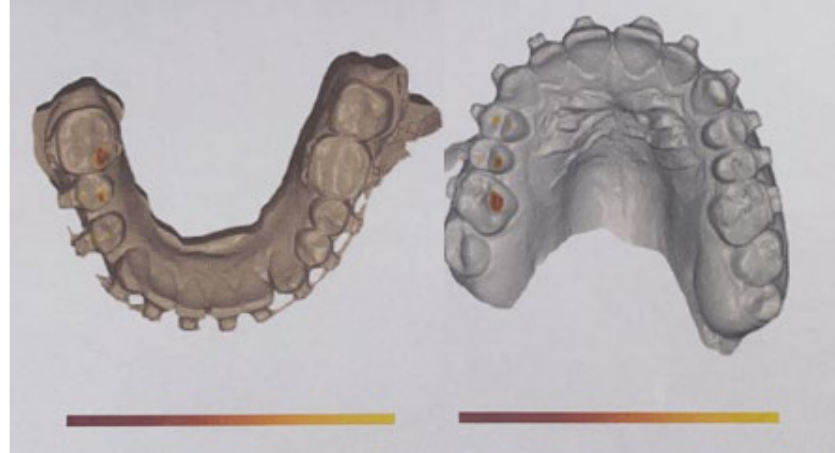
Figure 6. During preparation for surgery, premature or incorrect dental contacts in 3D planned models are easily highlighted and can be adjusted during surgery with diamond burrs to improve the occlusion and the final result. Some occlusal collisions can be easily removed before the surgery, while others require better correction intraoperatively.